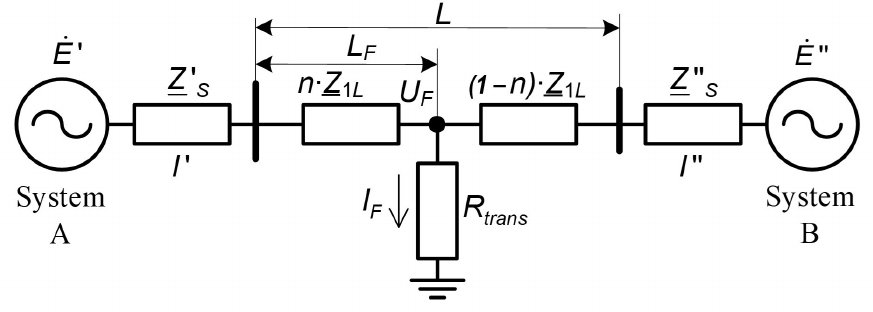
Figure 1. Simplified scheme of single OHPL with a double-sided power supply in case of short cir- cuit.